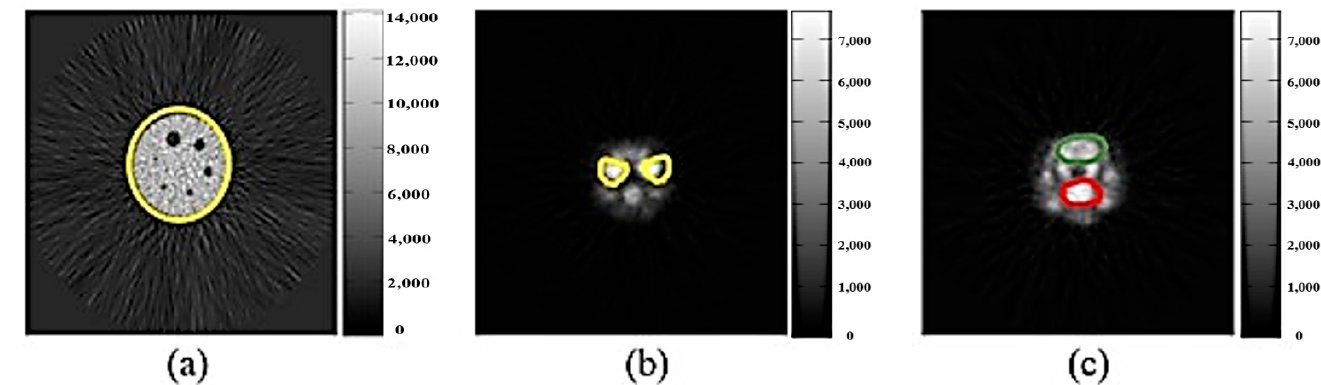
Figure 6. ROI selection of the ( a ) Deluxe Jaszczak phantom and ( b ) Harrington gland, sublingual gland, and ( c ) brain of rats; the SNRs of the ROIs were calculated to evaluate the image quality after MSO processing.